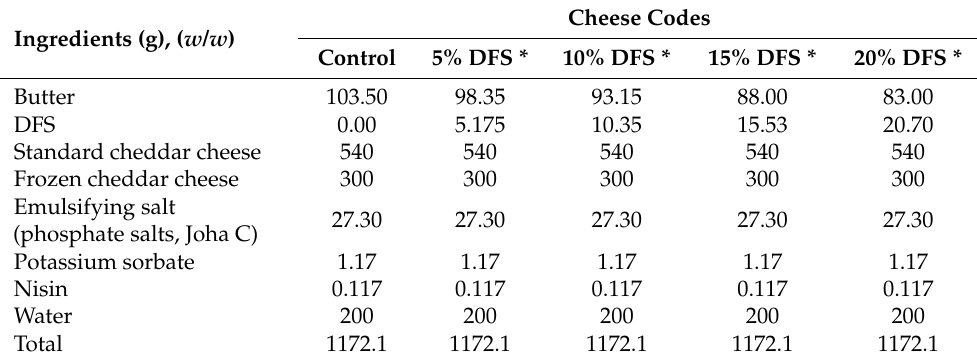
Table 1. Chemical ingredients and experimental design of block-type processed